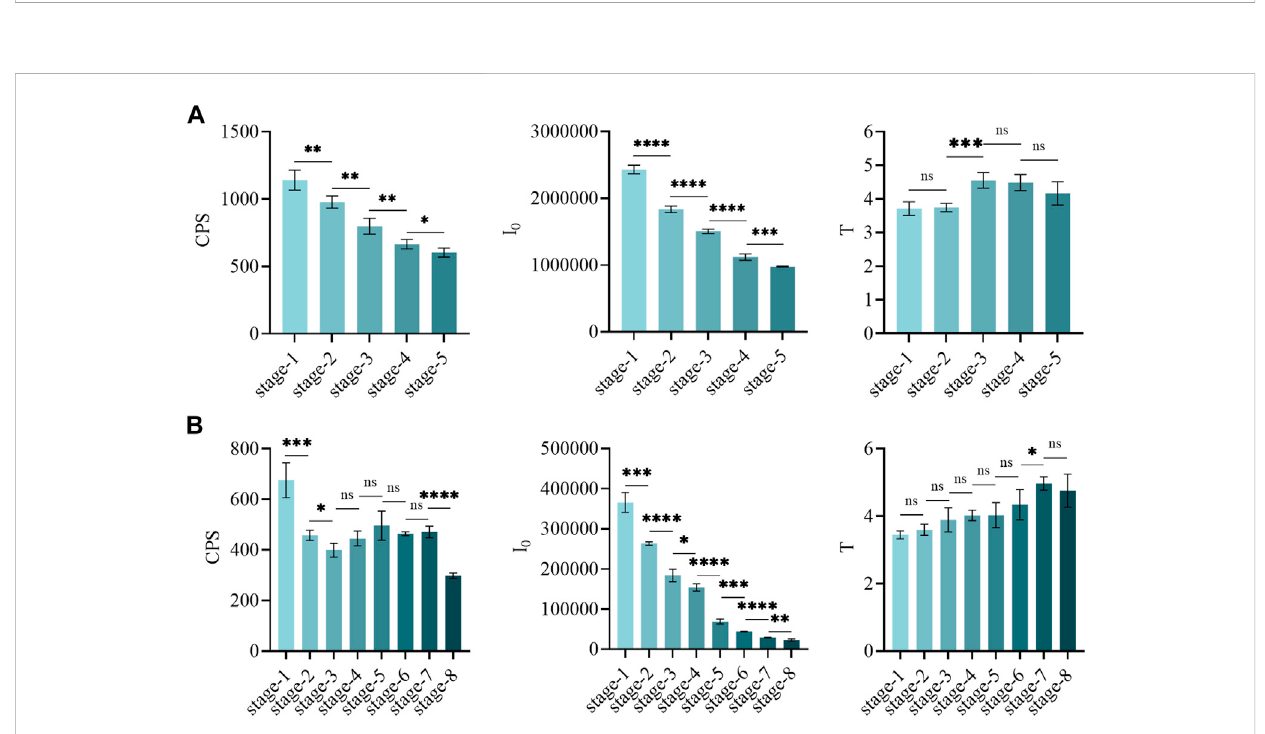
The t-test in biophoton parameters of motherwort and saf fl ower in different growth stages. (A) Motherwort. (B) Saf fl